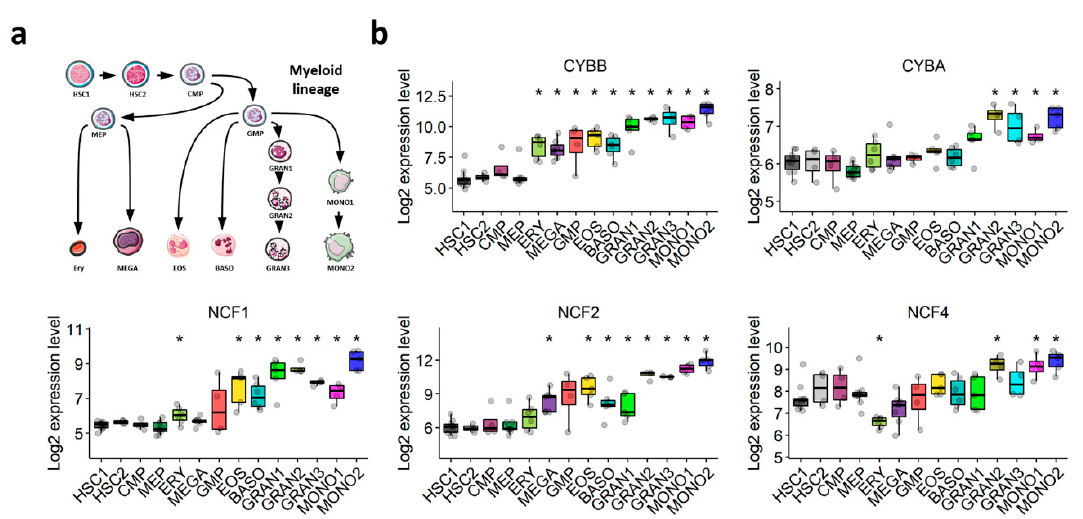
Figure 3. Expression profile of genes coding for NOX2 subunits throughout normal myeloid differentiation (GSE24759). ( a ) Schematic representation of the myeloid differentiation hierarchy depicting the analyzed populations. ( b ) Boxplots showing the expression of genes coding for the subunits of the NOX2 complex in myeloid subsets. Wilcoxon’s rank-sum test followed by BH-adjustment was used for the pairwise comparisons between the HSC1 population and the other populations. *: p < 0.05. HSC1: CD133 + CD34 dim HSCs; HSC2: CD38 − CD34 + HSCs; CMP: common myeloid progenitor; GMP: granulocyte/mono- cyte progenitor; MEP: megakaryocyte/erythroid progenitor; GRAN1: colony-forming unit-granulocyte; GRAN2: granulocyte (neutrophilic metamyelocyte); GRAN3: granulocyte (neutrophil); EOS: eosinophil; BASO: basophil; MONO1: colony-form- ing unit-monocyte; MONO2: monocyte, Ery: CD34 − CD71 − GlyA + erythroid; MEGA: megakaryocyte. 3.5. NOX2 Complex Subunits are Depleted in LSCs and at Relapse In order to verify whether NOX can contribute to AML aggressiveness, we investi- gated the expression of NOX-coding genes in LSCs and in relapsed AML cells. First, we explored the NOX-expression profile in functionally-defined LSCs using a dataset (GSE76009) of mouse-engrafting primary human AML stem cells (LSC + ) and non-engraft- ing LSC-depleted (LSC − ) cells [33] . The expression of the catalytical subunits was exam- ined according to the expression status of the CD34 and CD38 cell surface markers. CYBB was the most expressed gene, compared to NOX1 , NOX3-5 and DUOX1/2 (Figure S1a).